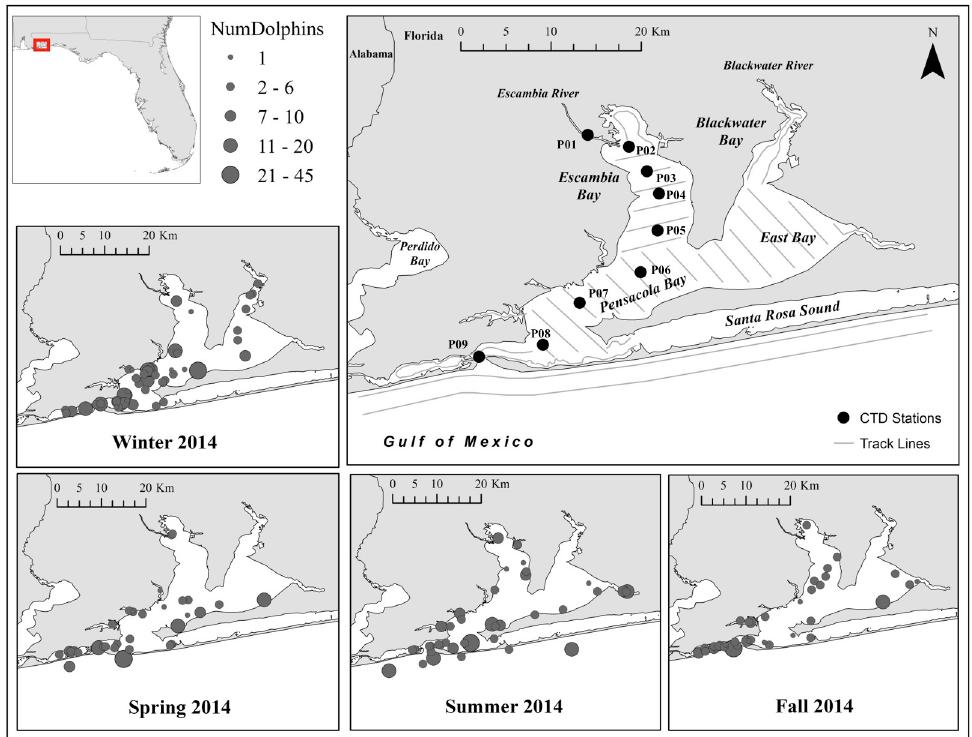
Fig 2. Study area showing survey area, track lines, and seasonal locations of all dolphin sightings (presented here as “best” estimates from the number of dolphins estimated in the field). Seasons defined in text; Coastal sightings were excluded for analyses; CTD stations are those monitored by the EPA (discussed in text) and are labeled in accordance with a previous publication [13].